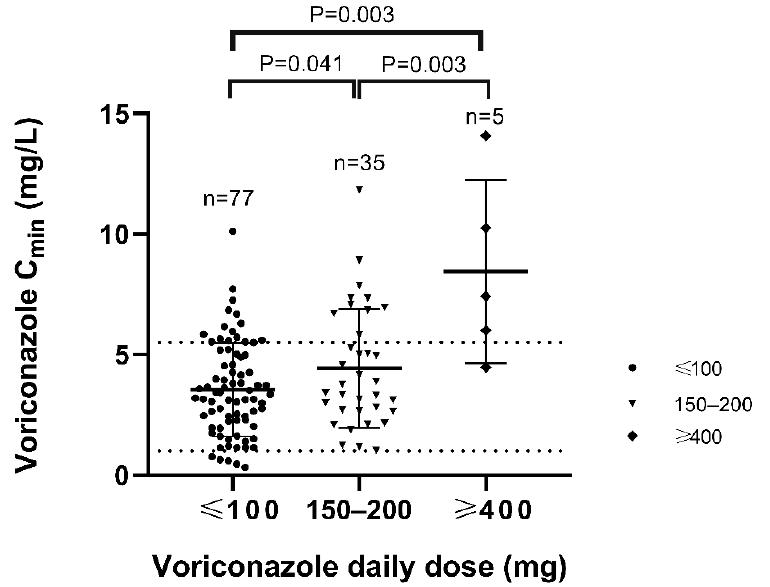
Figure 5. Distribution of voriconazole trough levels over daily dosages. The numbers of measure- ments for each daily dose are reported.